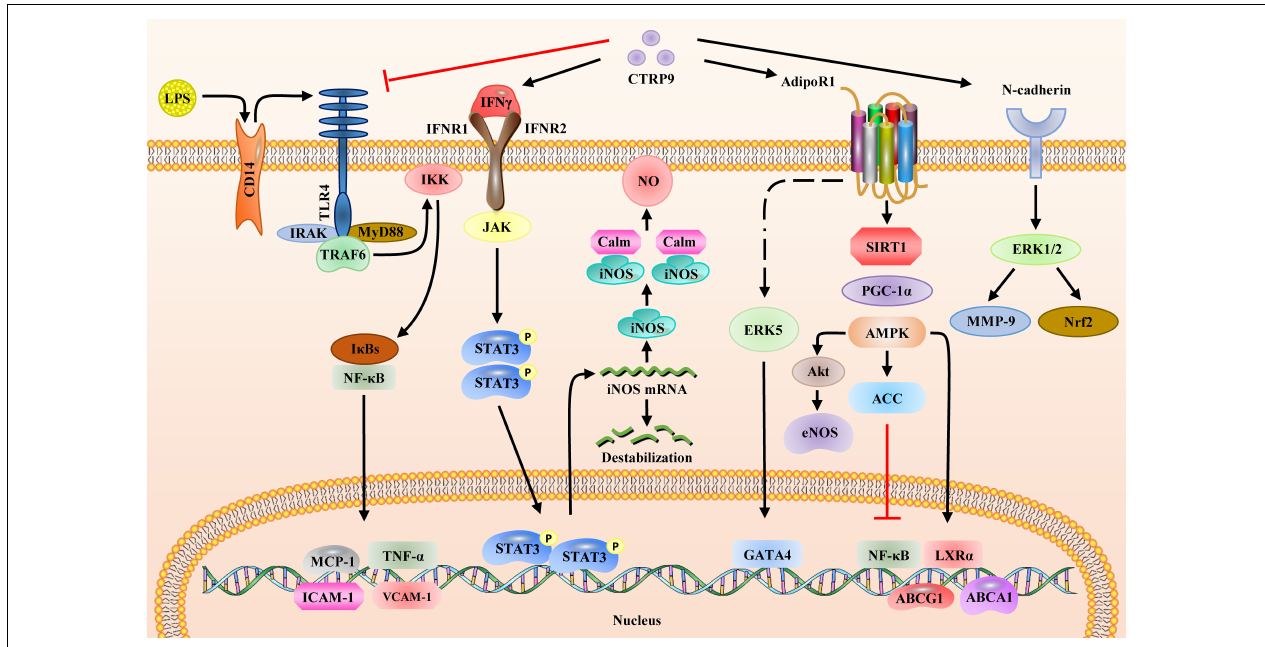
FIGURE 4 | Signaling pathways regulated by CTRP9. CTRP9 binds and affects four receptors on the cell membrane and activates downstream signaling pathways: (1) LPS binds to membrane receptor CD14 to activate the TLR4 signaling pathway. I κ Bs bind to NF κ B to promote the expression of downstream inflammatory genes, including MCP-1 , TNF- α , ICAM-1 , and VCAM-1 . CTRP9 blocks the activation of TLR4 receptors via LPS. (2) CTRP9 associates with IFN γ to activate the JAK/STAT3 pathway, thus upregulating the gene and protein expression of iNOS. (3) CTRP9 associates with AdipoR1 to upregulate the SIRT1/PGC1 α /AMPK pathway, activate ACC and inhibit the expression of nuclear transcription factor NF κ B, upregulate LXR α and promote the expression of ABCA1, and upregulate ABCG1 to activate Akt, thereby increasing eNOS expression; (4) CTRP9 associates with N-cadherin to activate ERK1/2 and upregulate MMP-9 and Nrf2. AMPK, AMP-activated protein kinase; CD14, cluster of differentiation 14; eNOS, endothelial nitric oxide synthase; ERK1/2, mitogen-activated protein kinase; ICAM-1, intercellular adhesion molecule 1; IFN γ , interferon gamma; iNOS, nitric oxide synthase 2; I κ B, inhibitor of nuclear factor kappa B kinase subunit beta; JAK, Janus kinase 2; LPS, lipopolysaccharide; LXR α , nuclear receptor subfamily 1 group H member 3; MMP-9, matrix metalloproteinase; NF κ B, nuclear factor-kB; Nrf2, nuclear factor, erythroid 2 like 2; PGC1 α , peroxisome proliferator activated receptor gamma coactivator 1 alpha; SIRT1, sirtuin 1; STAT3, signal transducer and activator of transcription 3; TLR4, toll-like receptor 4; VCAM-1, vascular cell adhesion molecule